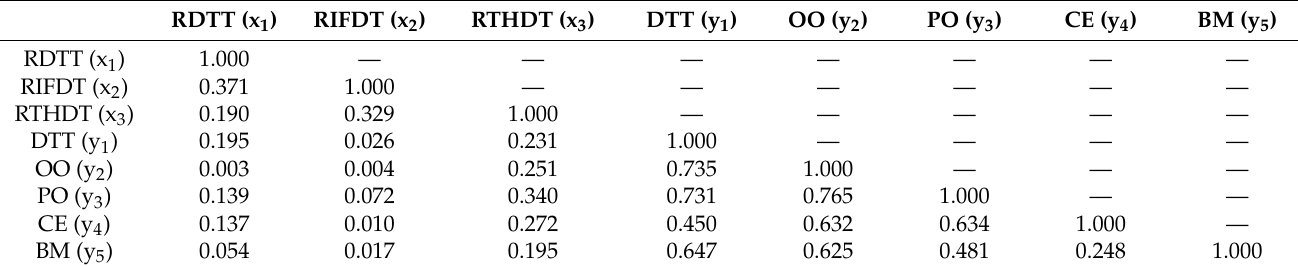
Table 2. Correlation of input and output variables.